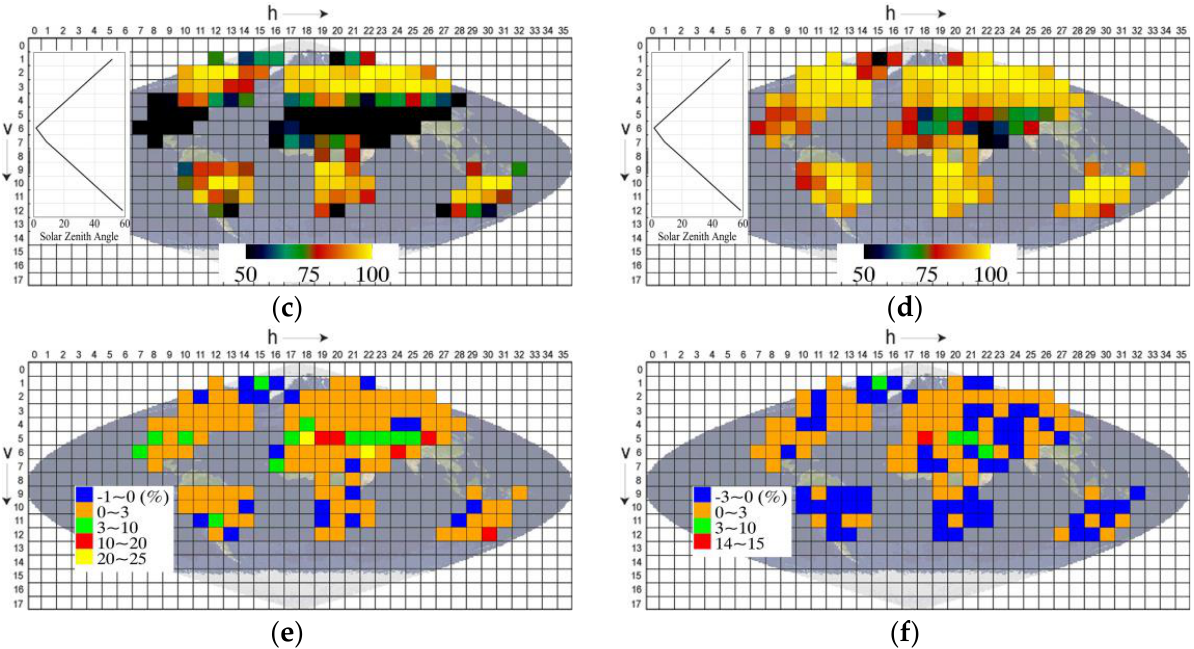
Figure 10. The global distribution of F vol ( a ) and F geo ( b ) based on the high-quality MODIS BRDF data on DOY 170, 2010: ( c , d ) the global distribution of P 0.02 based on nadir reflectance ( c ) and F- based albedo ( d ). The solar zenith angle at local solar noon for each row is also shown; ( e , f ) the difference between F L - and F -based P 0.02 and the difference between F L - and F N -based P 0.02 .